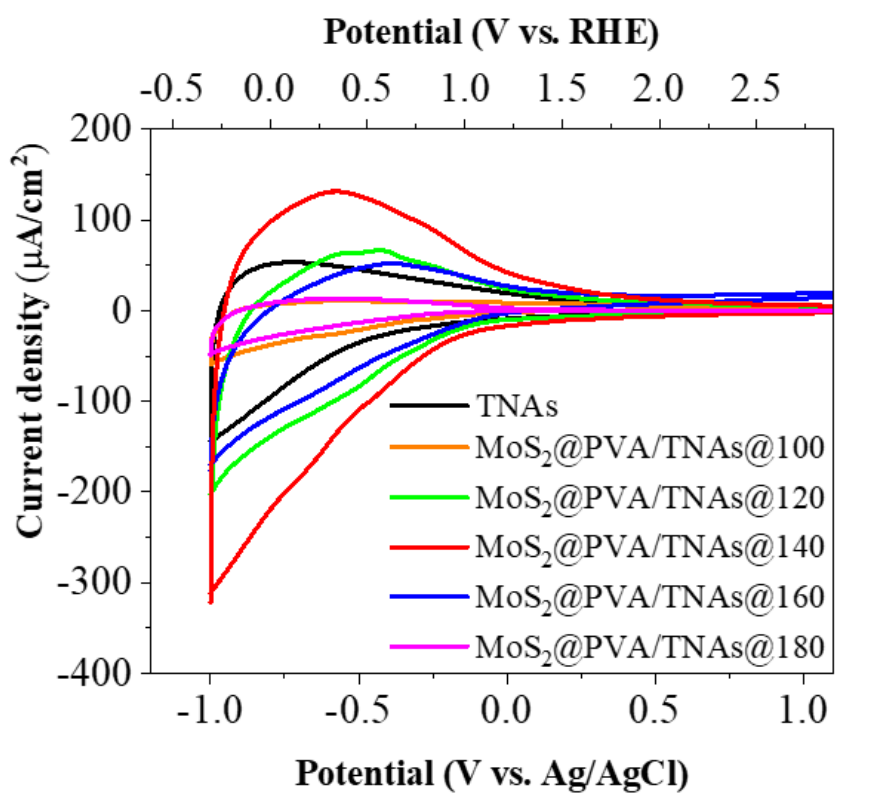
Figure 2. CV curves of MoS 2 @PVA/TNAs at different thermal treatment conditions of PVA. (Scan rate: 10 mV s − 1 ).